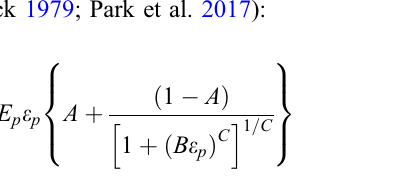
Fig. 4a, the compressive stress–strain model of concrete